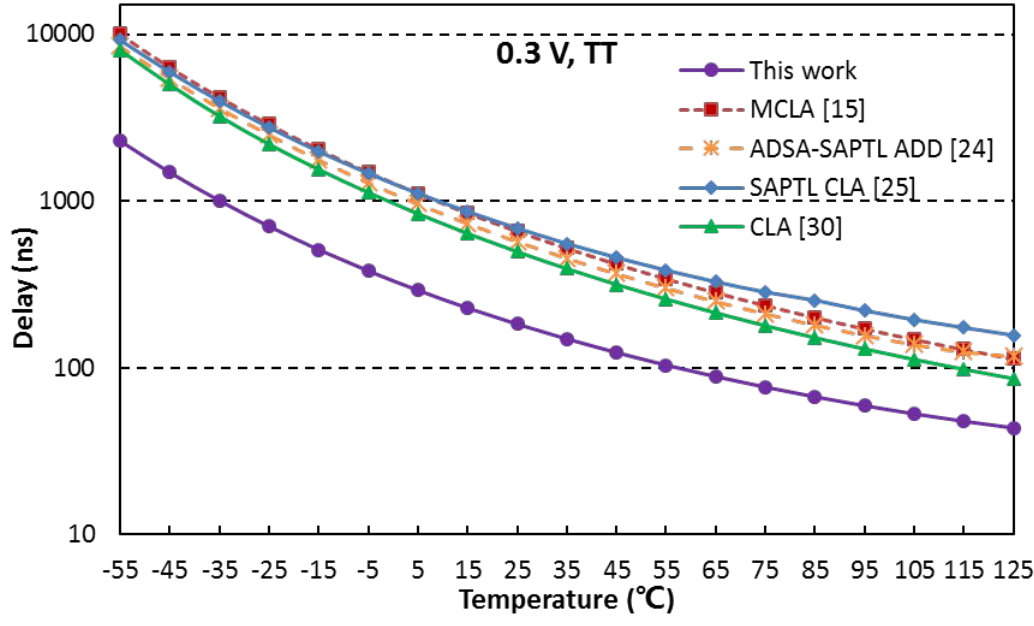
Figure 13. The performance variety with